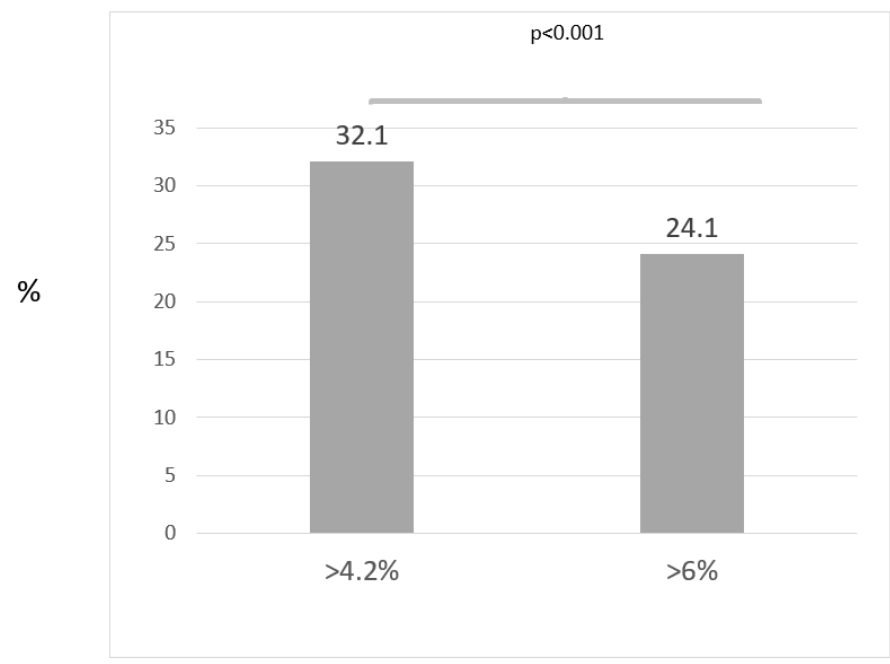
Figure 1 . The rate of GERD diagnosis using different pathological AET cut-offs. Figure 1. The rate of GERD diagnosis using different pathological AET